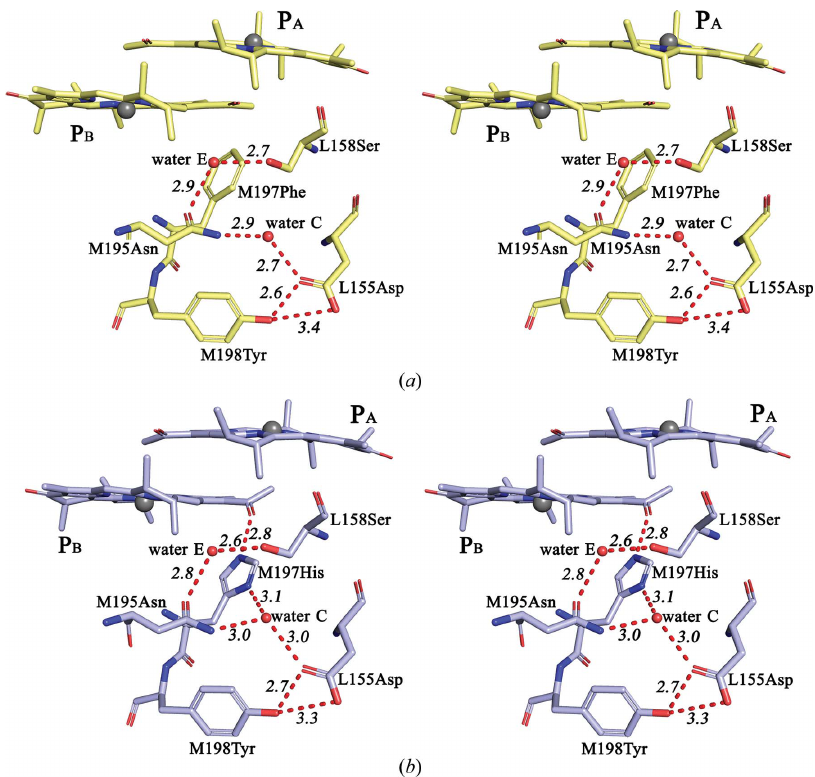
Figure 4 Stereoviews of the hydrogen-bonding networks in the vicinity of the M197 residue in the WT RC ( a ) and F(M197)H RC ( b ). All distances are shown in A˚